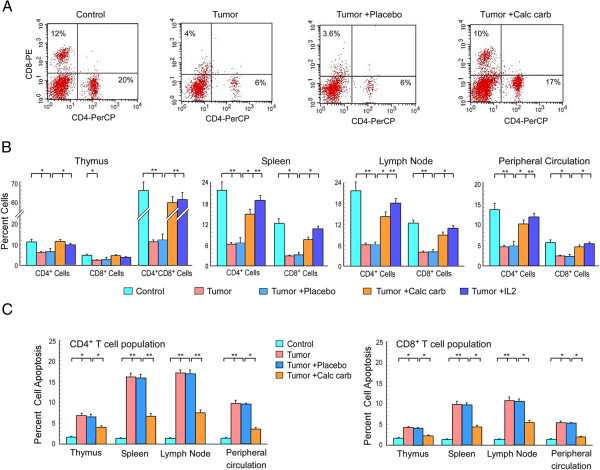
Calcarea carbonica restores tumor-induced depletion of T cell populations. Lymphocytes from thymus, spleen, lymph-node and peripheral circulation of untreated or placebo-/calcarea carbonica-treated tumor-bearing mice were analyzed flow cytometrically to quantitate percentages of CD4+/CD8+ populations. (A) Flow cytometric dot plot shows CD4+ and CD8+ T cell population in the draining lymph node of untreated or placebo-/calcarea carbonica-treated tumor-bearing mice. (B) Graphical representation of flow cytometric data showing percentages of CD4+ and CD8+ T cells in thymus, spleen, lymph-node and peripheral circulation of untreated or placebo-/calcarea carbonica-/IL2-treated tumor-bearing mice. (C) Percent CD4+ and CD8+ T-cell apoptosis (Annexin-V-positivity) from the same experimental sets were determined flow cytometrically at 21 day of drug treatment. The values are mean ± SEM of five independent experiments. *p < 0.05 and **p < 0.001 when compared with respective non-tumor/tumor-bearing control sets and placebo/drug-treated sets.